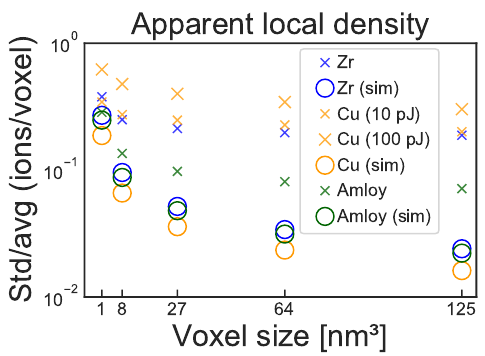
Figure A1. Reconstructed apparent local density variations (expressed as standard deviation divided by mean) for the different sample types and voxel